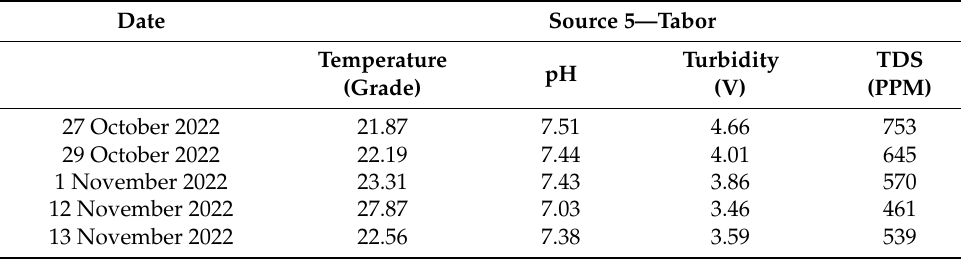
Table 5. Water source five